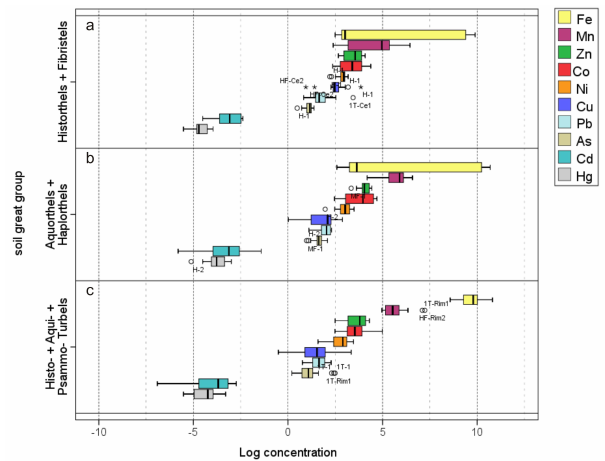
Fig. 3. Log-boxplot comparison of gravimetric concentration lev- els (in mgkg − 1 ) and variations of 10 elements in soil great groups based on three soil suborders Turbels, Histels and Orthels. Note that concentrations for all elements were log-transformed prior to